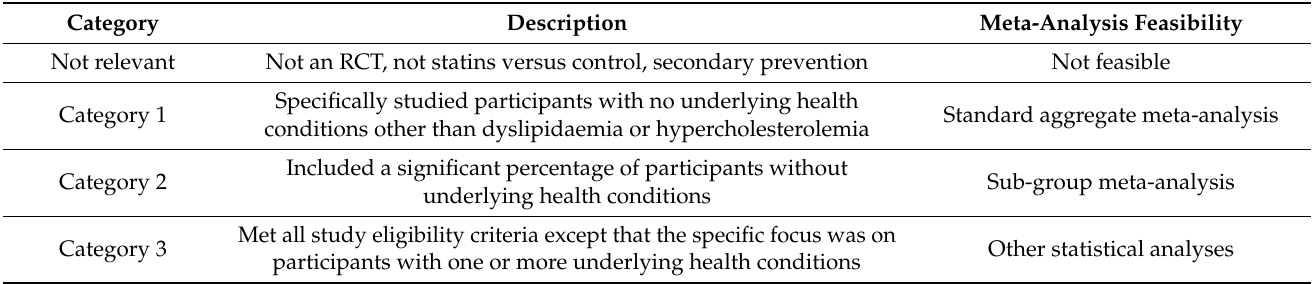
Table 1. Randomised Controlled Trial (RCT) classification